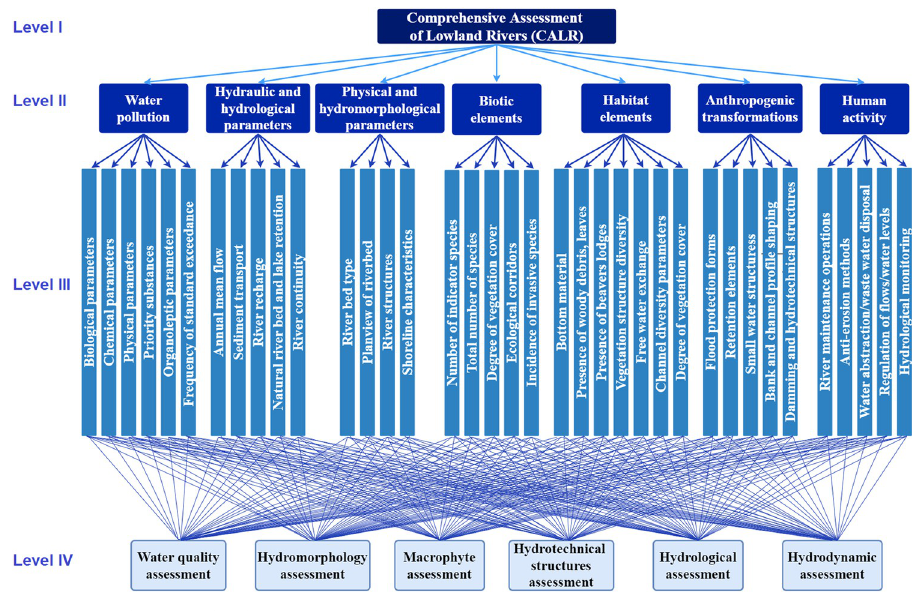
Fig 5. Hierarchical tree for the AHP